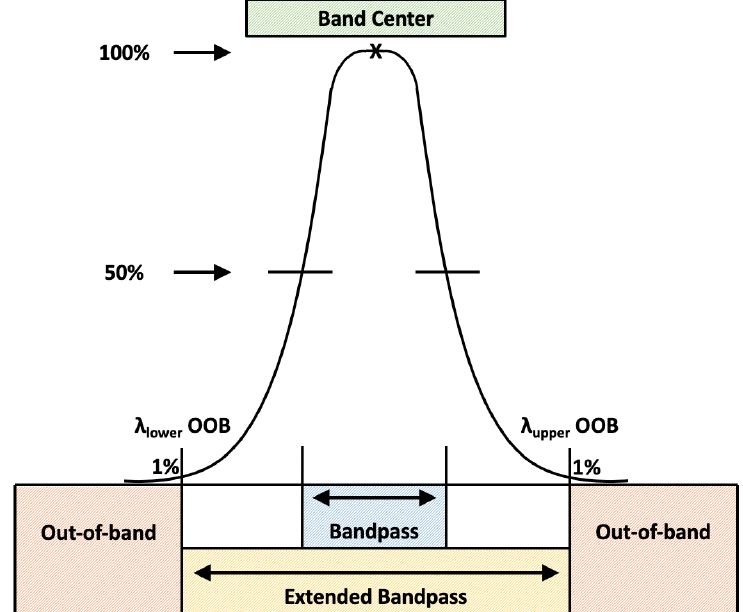
Figure 1. Schematic of “VIIRS spectral performance specification metrics,” which is a recreation of “Figure 1” from the works of Moeller et al. and Schwarting et al. [1,2,16–19]. The lower and upper wavelength 1% response limits that separate the extended bandpass and out-of-band (OOB) regions are designated as λ lower OOB and λ upper OOB, respectively.